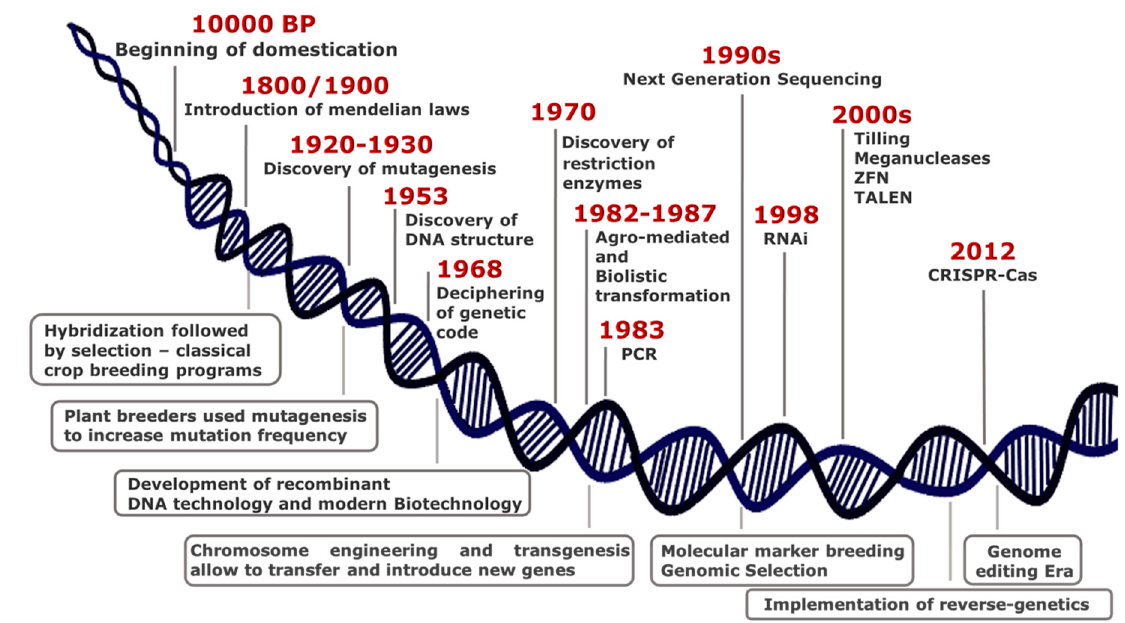
Figure 1. Agricultural biotechnology timeline. A timeline showing how biotechnology in agriculture has evolved, changing the ability to develop new crops.